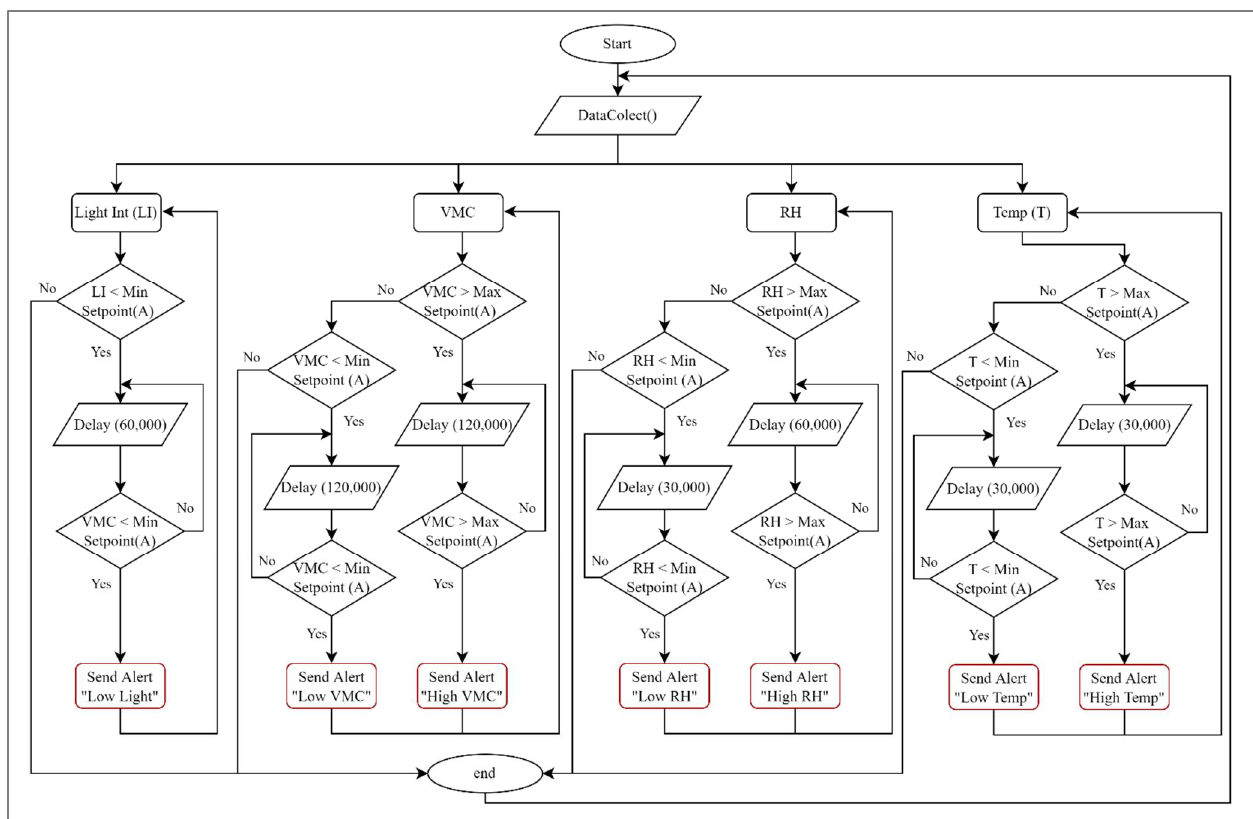
Figure 5. The alert flowchart for the E-VAS chamber. Temp (T) is the chamber temperature, RH is the chamber relative humidity, VMC is the volumetric moisture content of the substrate, Light Int (LI) is the light intensity, and Setpoint (A) is the alert setpoint.